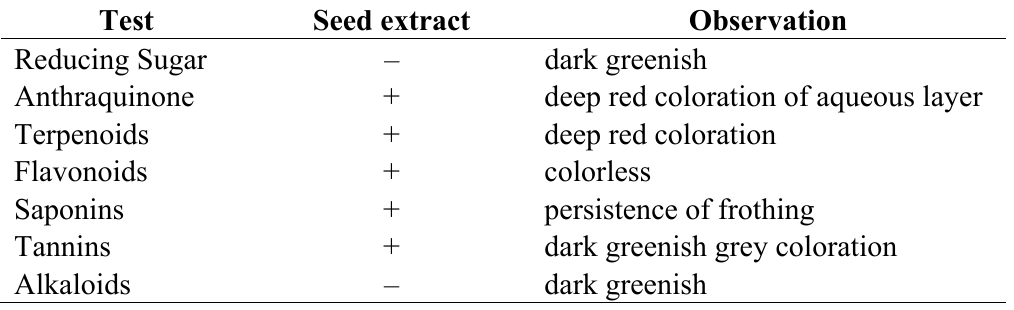
Table 1. The analysis of phytochemicals in the methanol seed extract of C.